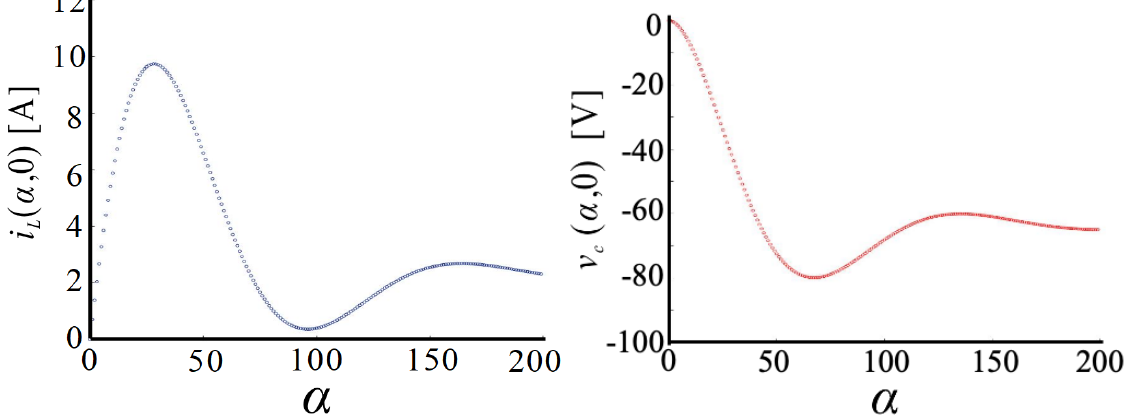
Figure 8. Graph of the ICCV at the beginning of the α -th switching period from S 4 parameters through analytical Equations (33) and (34).